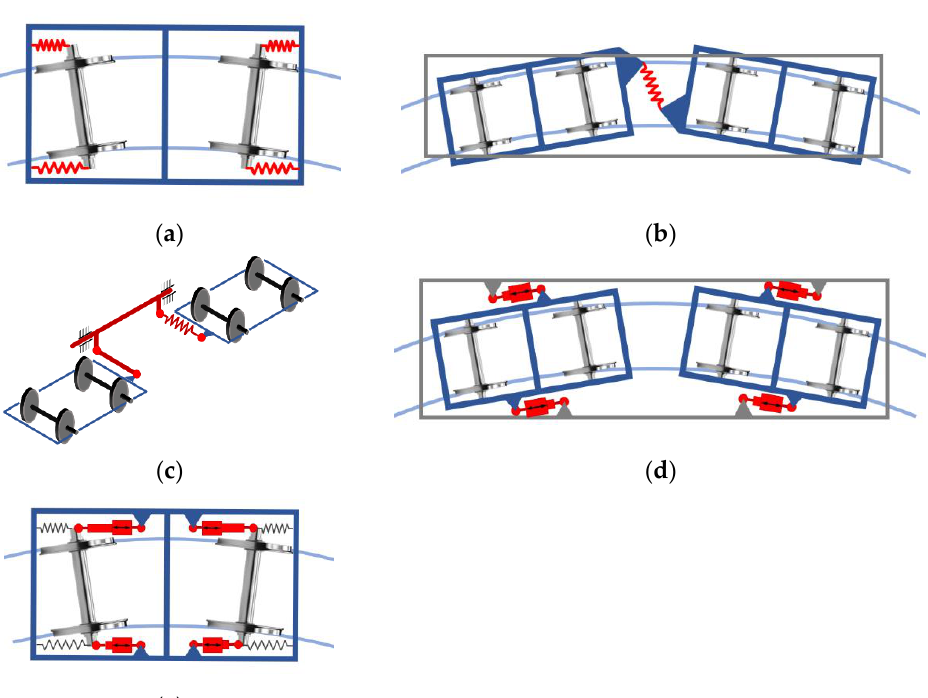
Figure 3. Vehicle configurations. YFS ( a ), MBC1 ( b ), MBC2 ( c ), AYD ( d ), and AWS ( e ). The parameters of mechanical bogie connections MBC1 and MBC2 (i.e., stiffness